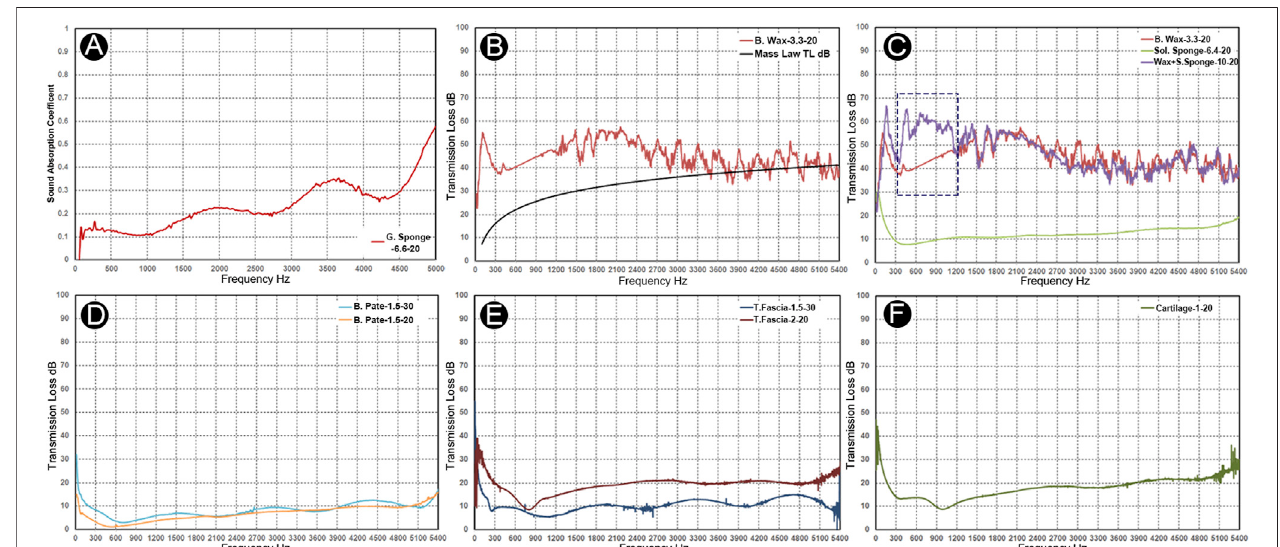
FIGURE7| Acousticabsorptionandinsulationpropertiesofthegraftsandbiomaterials.Nomenclature:materials-thickness-diameter. (A) Absorbentcoef fi cientvs. frequency graph of soft gelatin sponge. (B) Transmission loss vs. frequency graph of bone wax. (C) Transmission loss of bone wax (red), solidi fi ed gelatin sponge (yellow), and solidi fi ed gelatin sponge – bone wax complex (purple). Notice an evident increase of the sound insulation volume at 200 – 1,200 Hz of the complex material specimencomparedtothebonewaxspecimen(bluedottedrectangle). (D) Transmissionlossvs.frequencygraphofthebonepatesamples. (E) Transmissionloss vs. frequency graph of the two temporalis fascia specimens. (F) Transmission loss vs. frequency graph of the auricular cartilage.